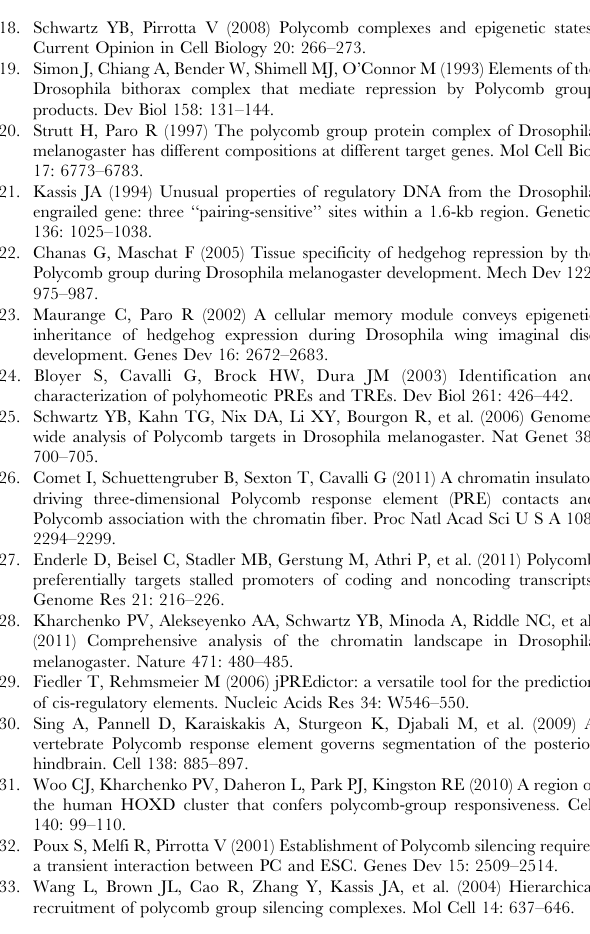
controls (black). Different mutant configurations are color coded and specified on the top ( del(10 ), del(10-11) , del(9-12) , del(10-13) , del(11-R5) ). dN stands for HoxdN . NA refers to the absence of the given DNA segment in the specified allele. NI refers to mutant alleles which where not included in the experiment ( Suz12 on both del(10-11) and del(11-R5) ). (TIF) Figure S2 Effect of large deletions upon the H3K27me3 profiles. (A) Wild type genomic landscape of the murine HoxD cluster and flanking gene deserts. (B) H3K27me3 profiles of wild type and deleted animals. Genotypes are specified on the left. (TIF) Figure S3 Southern blot of transgenic animals. Southern blot using a Hoxd10 specific probe (see Figure 4B). Restriction enzymes used for the experiments are specified below and mutant strains are on the top. Wild type bands are depicted by the black arrows whereas transgenic fragments are shown in red. The founders ( + / 2 ) exhibit two bands before being crossed over a Hoxd10 deletion, where only the transgenic band remains ( 2 / 2 ). A wild type sample ( + / + ) was used as control (right panel). The positions of both the restriction sites for PvuII and HindIII and the probe used for southern blot are depicted on the wild type profile in Fig. 4B. Figure S4 H3K27me3 profiles in pluripotent and terminally differentiated cells. A large (A) or focused (B) view of wild type H3K27me3 profiles from differentiated cells dissected from the